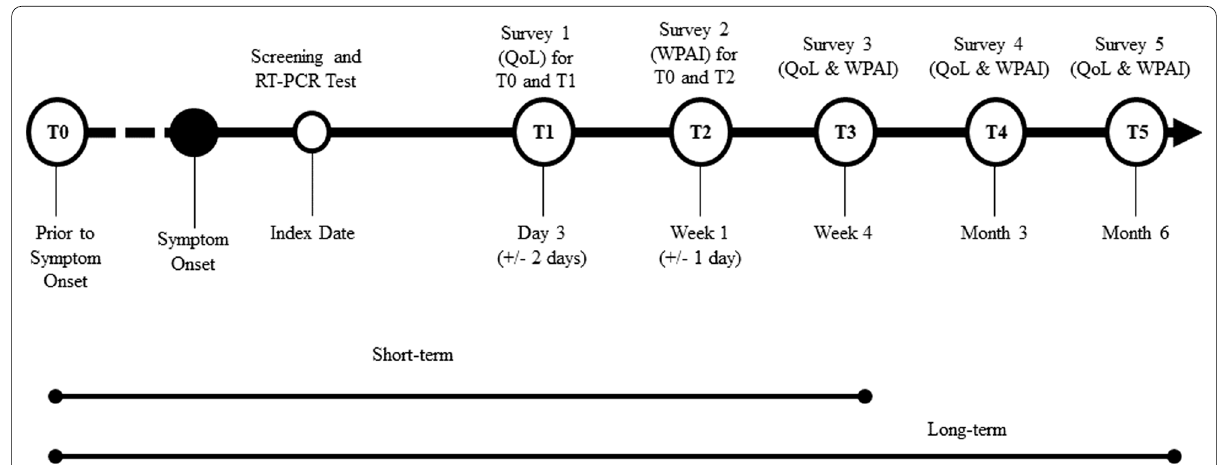
Fig. 1 Study design. Notes QoL refers to the EQ-5D-5L